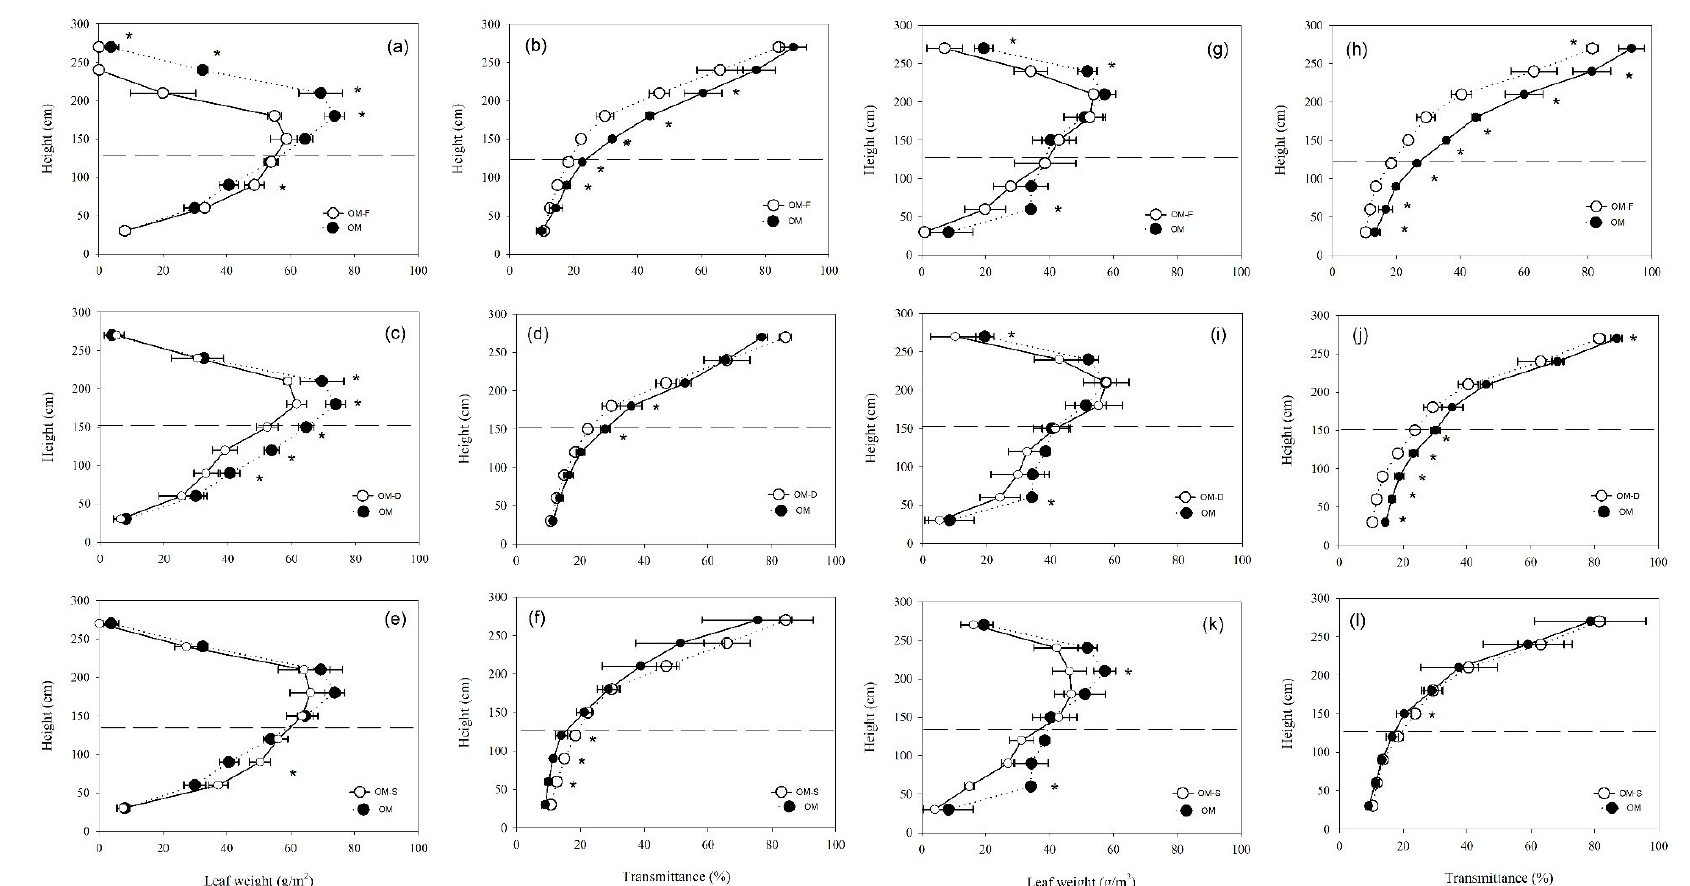
Figure 3. The vertical distribution of maize leaf weight and transmittance under different treatments, and the data was all collected in 2018 (sub ‐ graphs ( a – f )) and 2019 (sub ‐ graphs ( g – i )). Dotted line indicates the height of the ear; “*” represent significance at the 0.05 probability.